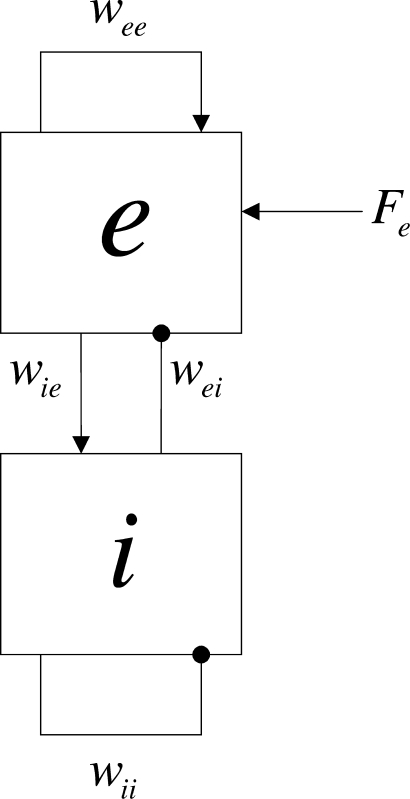
Model for Network with Tonic ActivityThe model consists of two coupled populations, excitatory and inhibitory. We assume the inhibitory population is not driven directly by external stimulation. Each population responds via a threshold linear response function, as described in Equation 15.